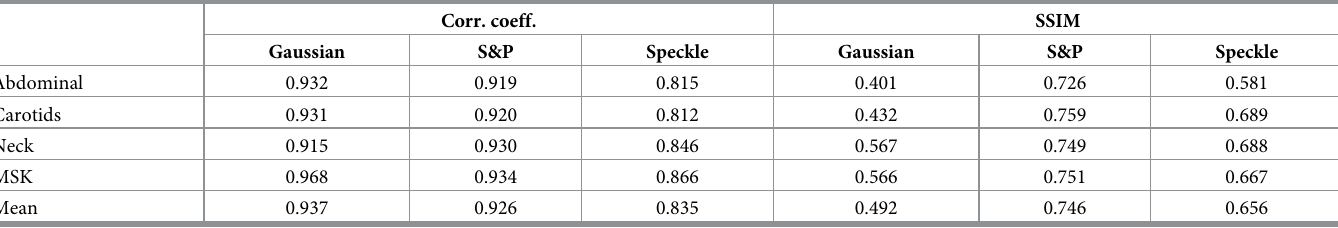
Table 1. Median comparison of SSIM and correlation coefficient for Db5 wavelet with decomposition level 3 and various noise levels and datasets. Corr. coeff.